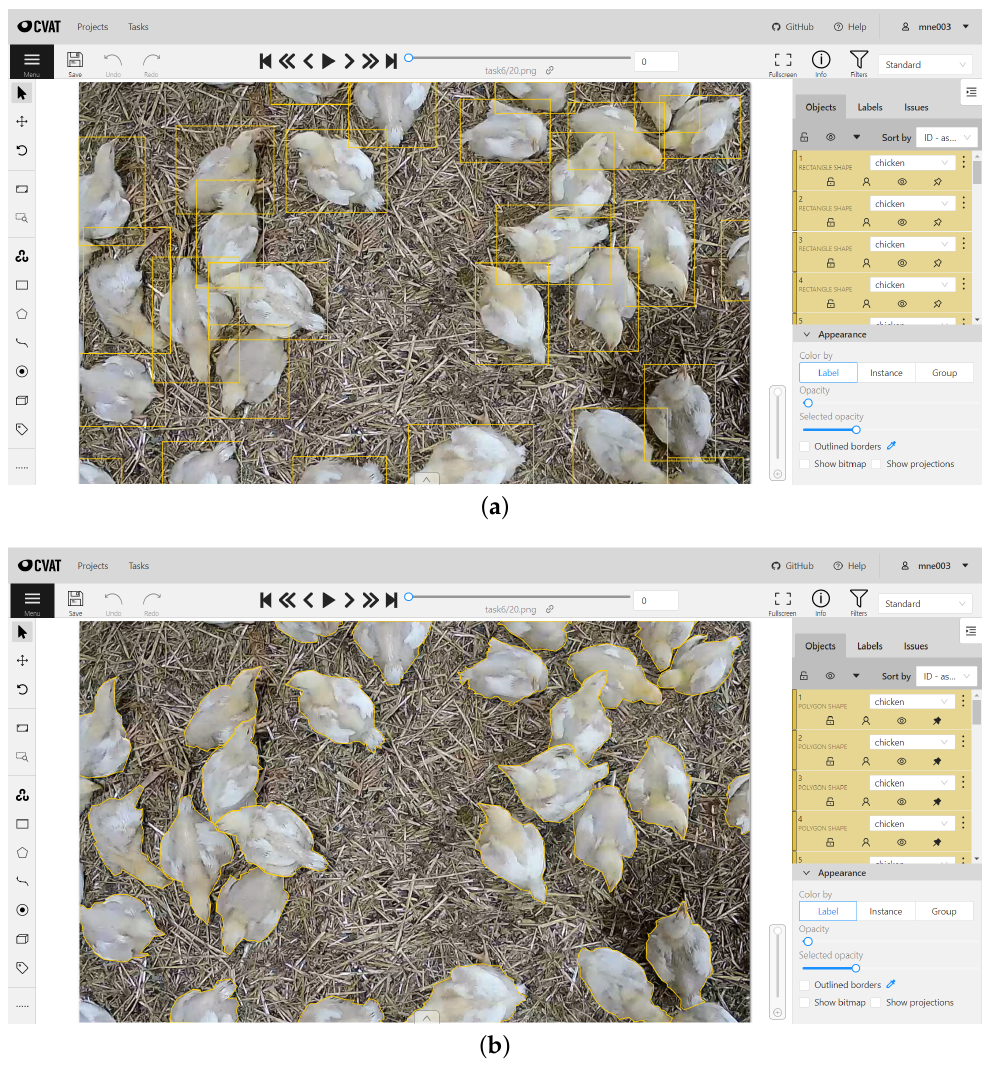
Figure 3. Annotation of the datasets using CVAT tool: ( a ) object detection labeling with rectangles ( b ) instance segmentation labeling using